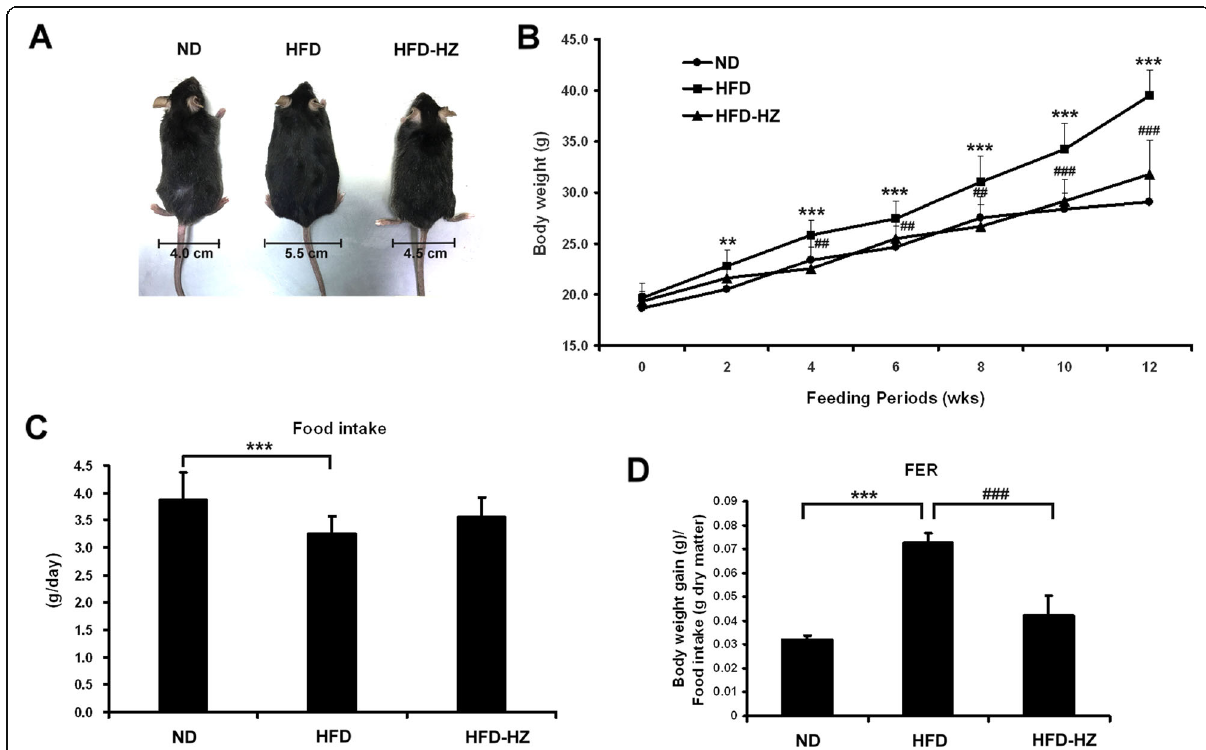
Fig. 3 The effect of HZ extract treatment on body weight and food intake in C57BL/6 J mice fed an HFD. a Changes in body shape and the waistline. b Changes in body weight. c Food intake. d Food efficiency ratio (Body weight gain/Food intake, FER). Data are shown as means ± SEM ( n = 10 per group). ND vs. HFD: * p < 0.05; ** p < 0.01; *** p < 0.001. HFD vs. HZ: # p < 0.05; ## p < 0.01; ### p <